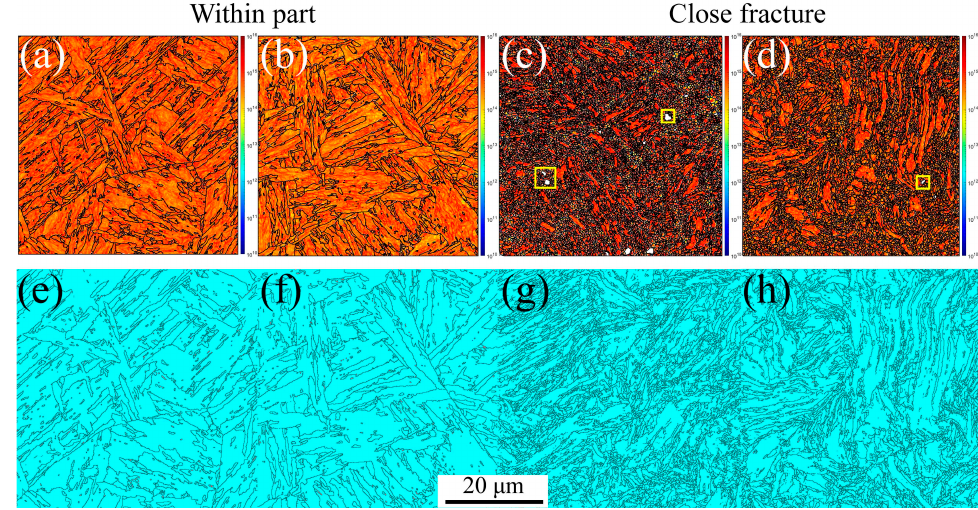
Figure 13. KAM, GND, and twinning maps under different strain gradients at the strain rates of 5 × 10 − 5 s − 1 under 430 and 630 °C (Voids are inside the yellow square). ( a – d ) GNDs and ( e – h ) twinnings.